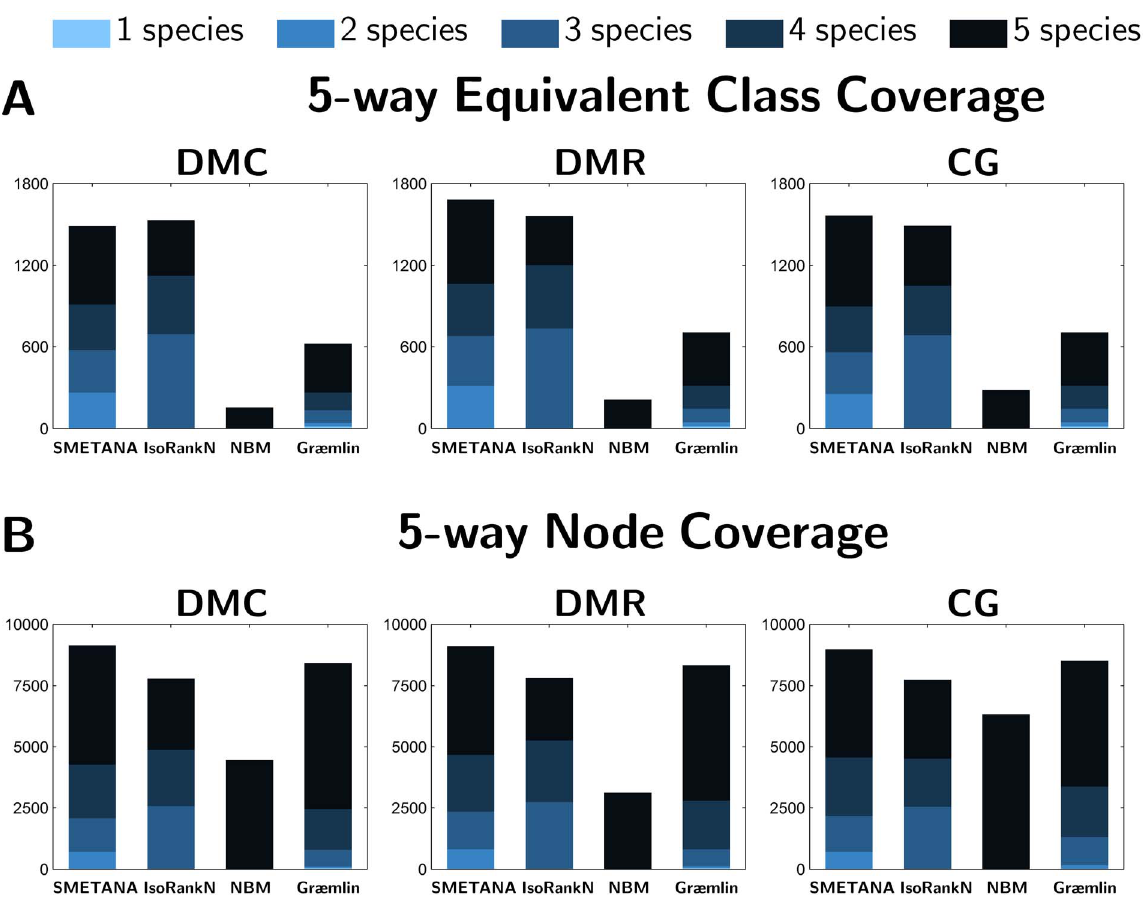
Figure 1. Performance of various network alignment algorithms. (A) Equivalence class coverage: Number of equivalence classes in the 5-way alignment experiment that contain nodes from k species ( 1 ƒ k ƒ 5 ). (B) Node Coverage: Number of nodes (i.e. proteins) that belong to equivalence classes that contain nodes from k species in the 5-way alignment.